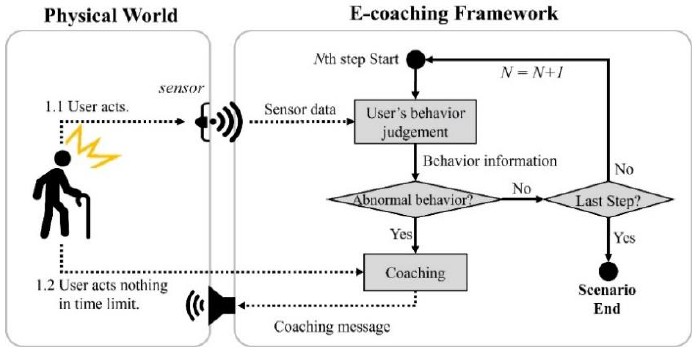
Figure 2. The flow of the ADL evaluation scenario in the proposed framework.